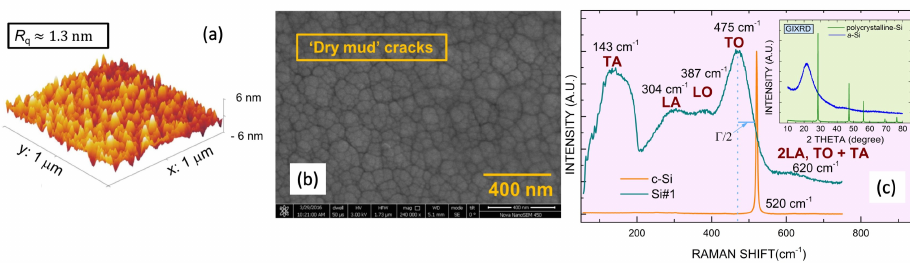
Figure 1. 3D AFM ( a ) and top-view SEM ( b ) images of a 4.4 Pa RFMS- a -Si sample (Si#1). ( c ) Room- temperature first-order Raman spectrum of the representative sample, Si#1, and also that for a poly-Si (crystallized by the use of CW-diode laser), respectively; in its inset, the GIXRD-patterns of the a -Si layer, together with that of the laser-crystallized